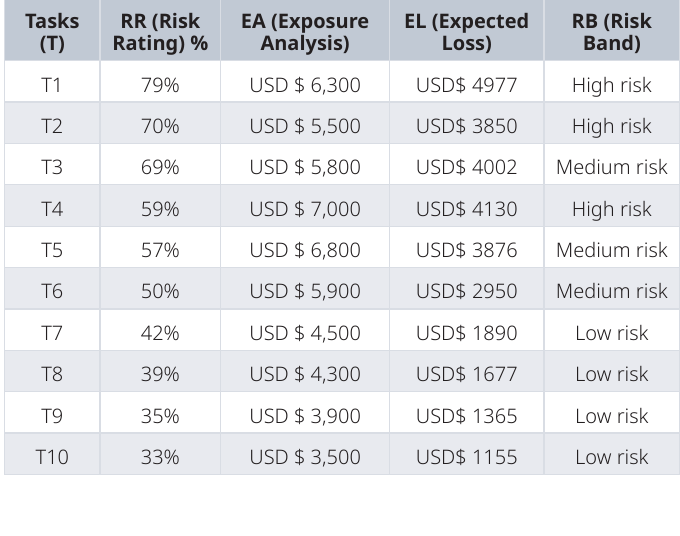
Table 1. Automated Risk Band (RB) Output.